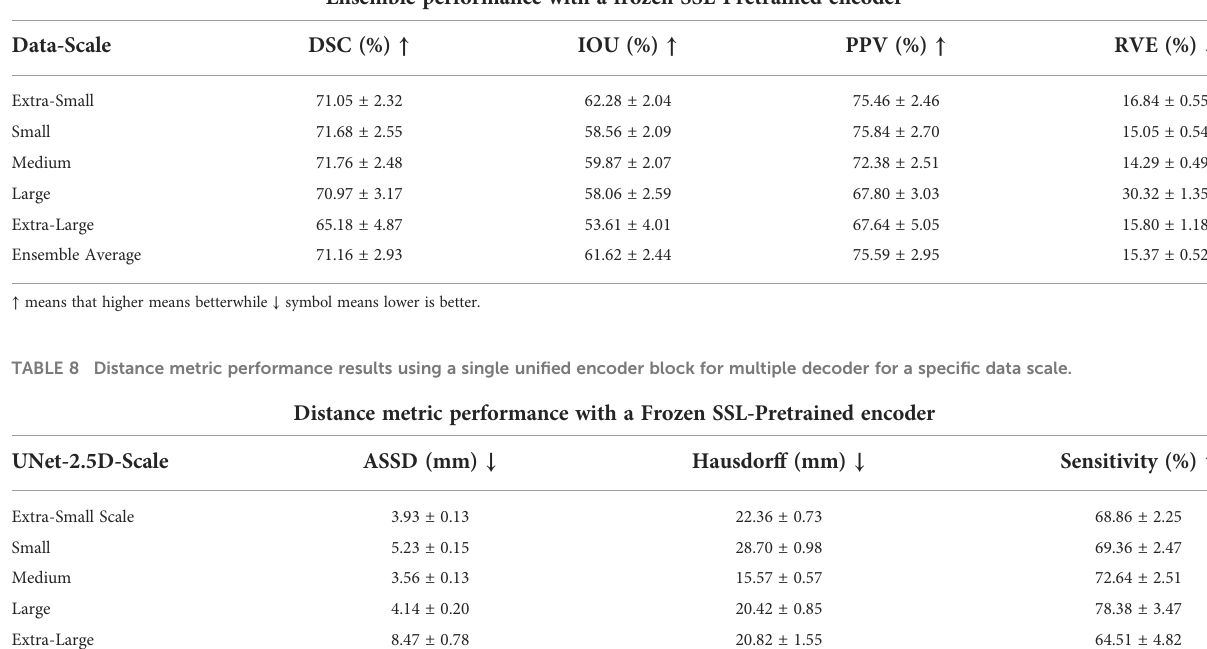
TABLE 7 Model ensemble performance for DSC, IOU, PPV and RVE using a single uni fi ed SSL-pretrained encoder hence, effectively training only the decoder block. Ensemble performance with a frozen SSL-Pretrained encoder